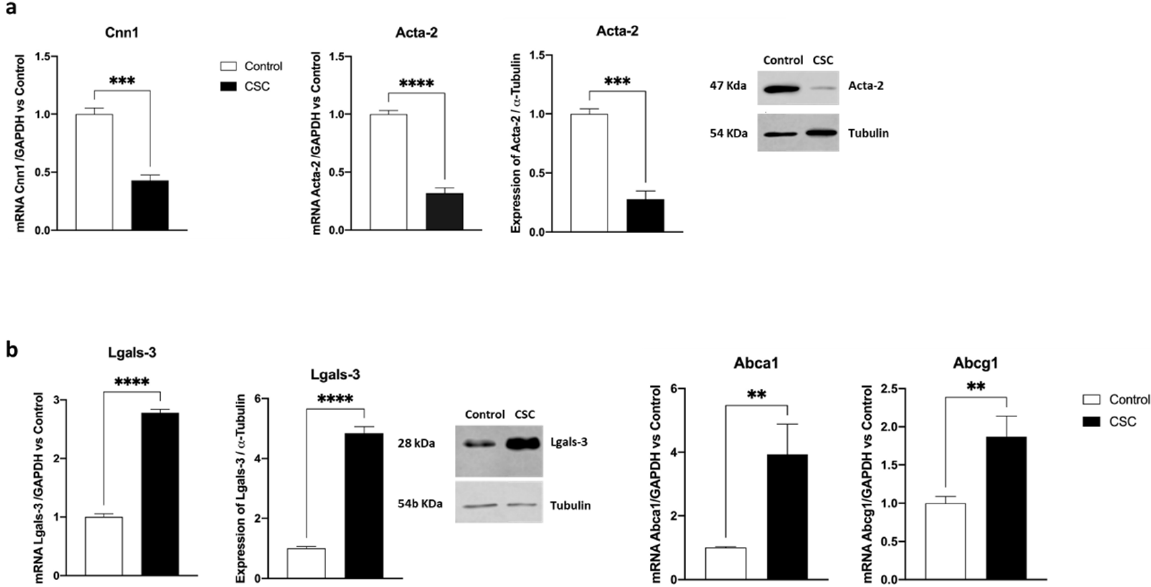
Figure 1. CSC induces a phenotypic switch in murine SMCs. Murine SMCs were incubated for 48 h with CSC (30 µg/mL). Then, the expression of contractile ( a ) or inflammatory ( b ) genes was evaluated using RT-PCR or WB analysis. Data are the mean ± SD of at least three experiments performed in triplicates. ** p < 0.01; *** p < 0.005; **** p < 0.001 vs. control.